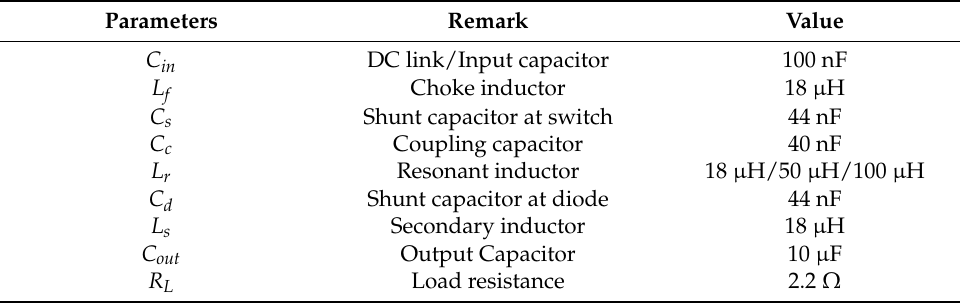
Table 1. Parameters of Class-E 2 power converter for